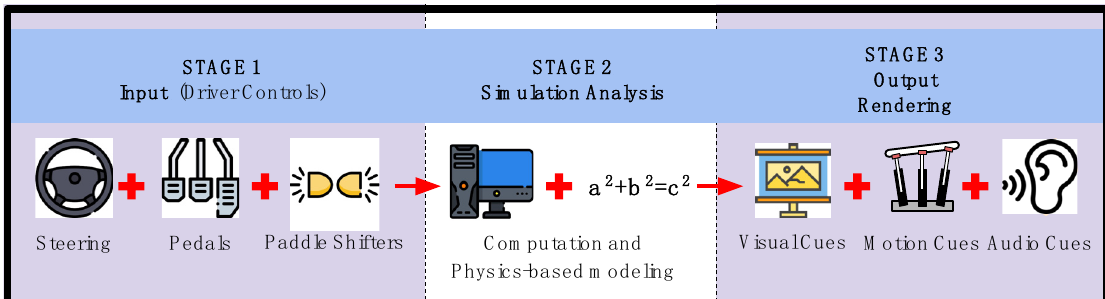
Figure 4. I/O signal pathway for training framework.